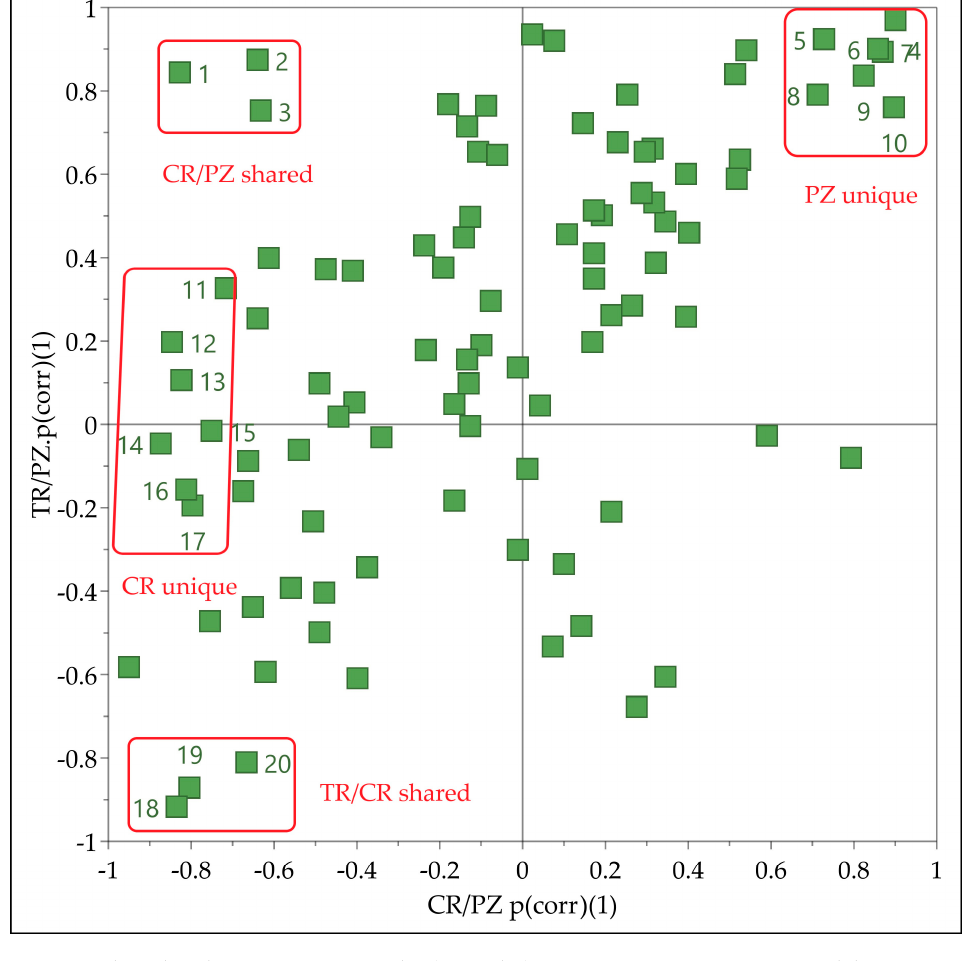
Figure 2. Shared and unique structure plot (SUS-plot) connecting two OPLS-DA models comprising cultivars CR versus PZ (M2) and TR versus PZ (M3). The most influential variables are marked with numbers corresponding to the metabolites depicted in Figure 3.